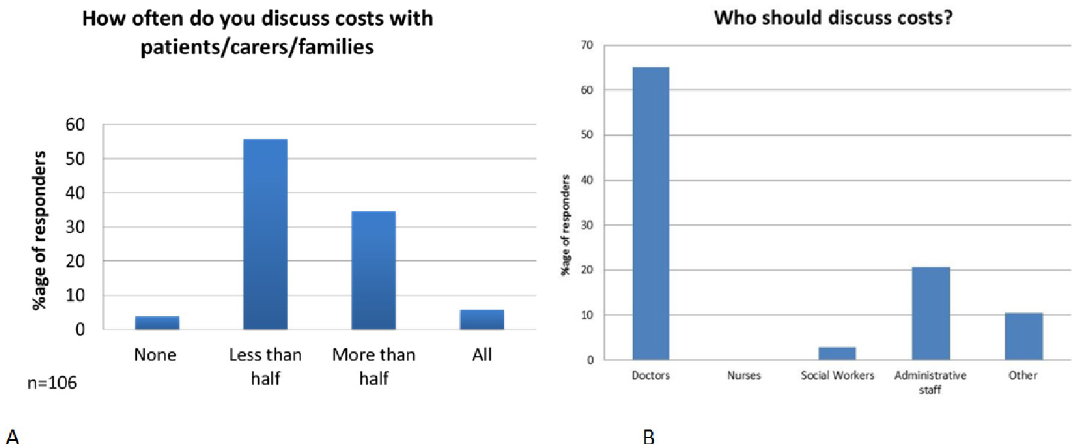
Fig 1. Discussions of costs in clinical practice. A: Reported frequency of discussions about costs in the past 12 months by oncologists. B: Clinic personnel reported as being responsible for discussion of costs.